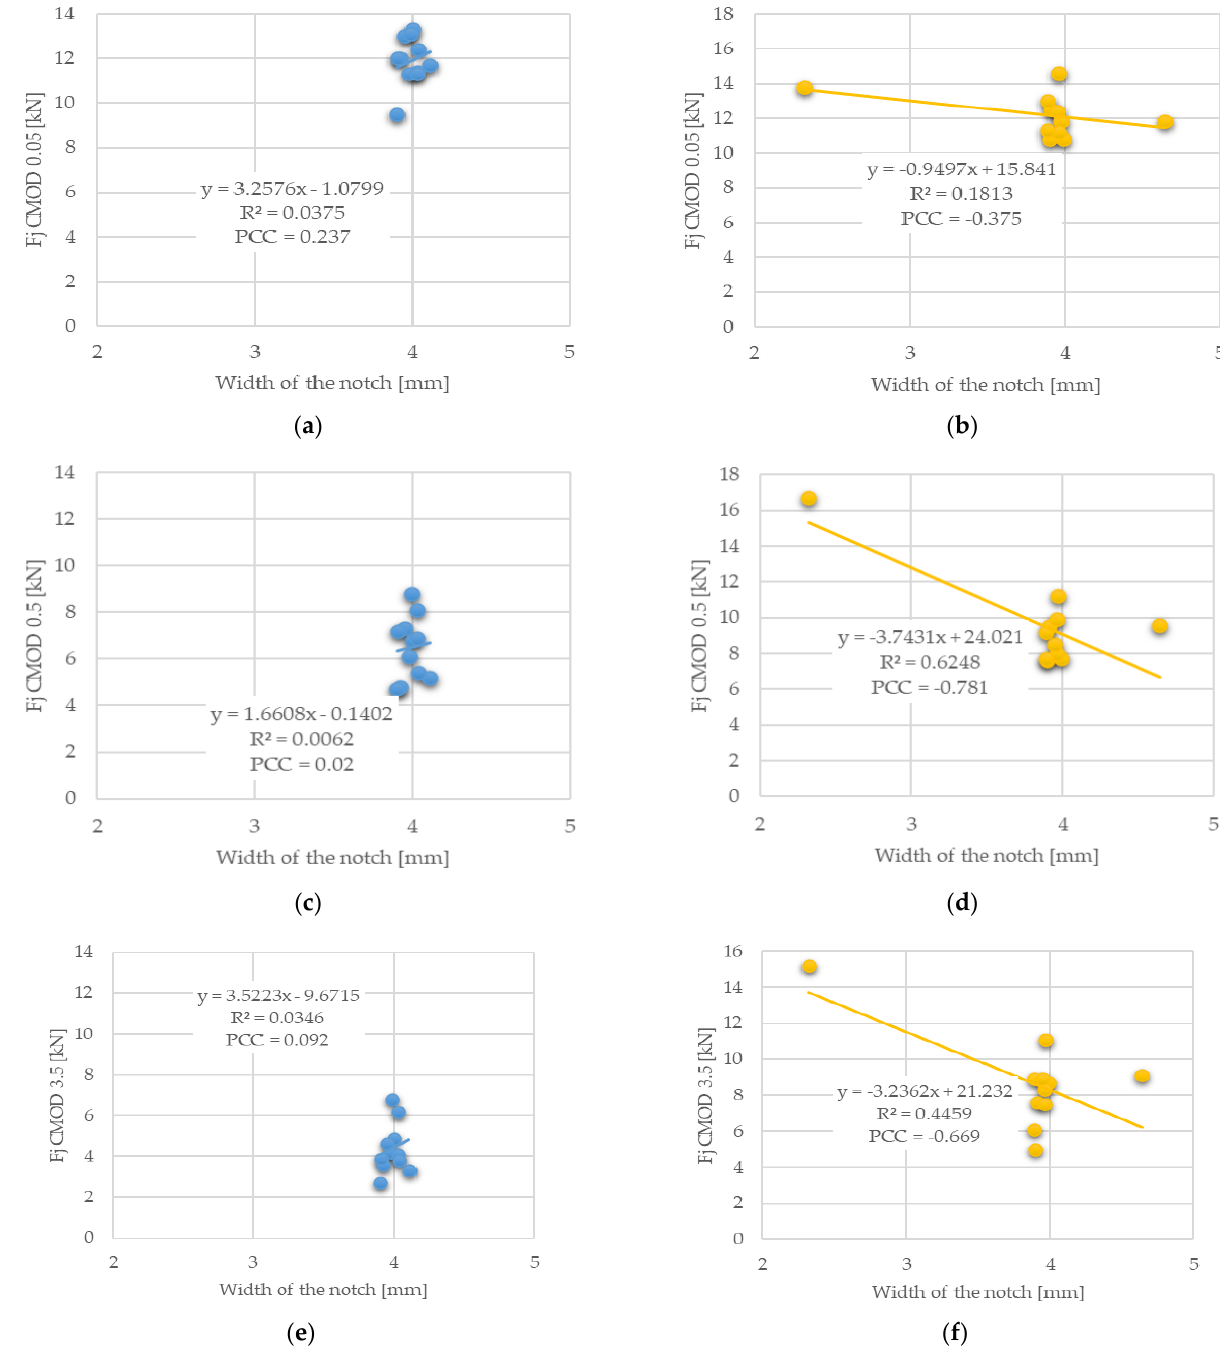
Figure 6. Width of the notch and load corresponding to CMOD 0.05 mm (limit of proportionality): fibre A ( a ), fibre B ( b ); CMOD 0.5 mm: fibre A ( c ), fibre B ( d ); CMOD 3.5 mm: fibre A ( e ), fibre B ( f ).